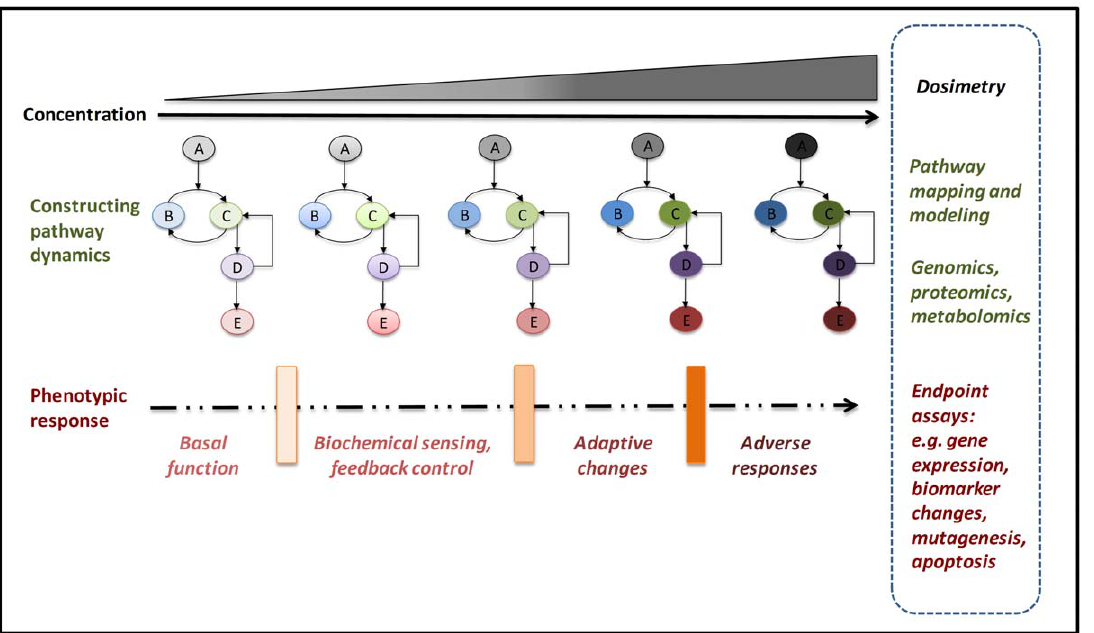
Figure 3. A schematic figure illustrating progressive activation of a prototype toxicity pathway, with attendant discrete phenotypic transitions. Text on right of figure shows proposed approaches for characterizing discrete transitions through multiple cellular phenotypes, i.e., (1) basal function, (2) minimally perturbed cellular states, (3) upregulation of adaptive, homeostatic gene batteries, and finally (4) overtly adverse states with excessive pathway perturbations. The structure of the circuitry with various embedded, nonlinear feedback loops is schematized in the middle panels. In the context of in vitro assay design, varying free concentrations of a test compound in the test media lead to increasing activation of pathway component (signaling protein) A, thereby driving pathway perturbations of signaling components B and C, and further signaling events downstream of C. Each of these steps is expected to be associated with specific alterations in gene expression, phenotypic read-out and pathway activation, identified by CSBP modeling. As the concentration increases, various portions of the network would be sequentially activated until full activation was achieved (indicated by progressively darker shading of pathway components). Full pathway activation triggers a robust response throughout the pathway circuitry, leading to adverse outcomes measurable in the cellular assay.